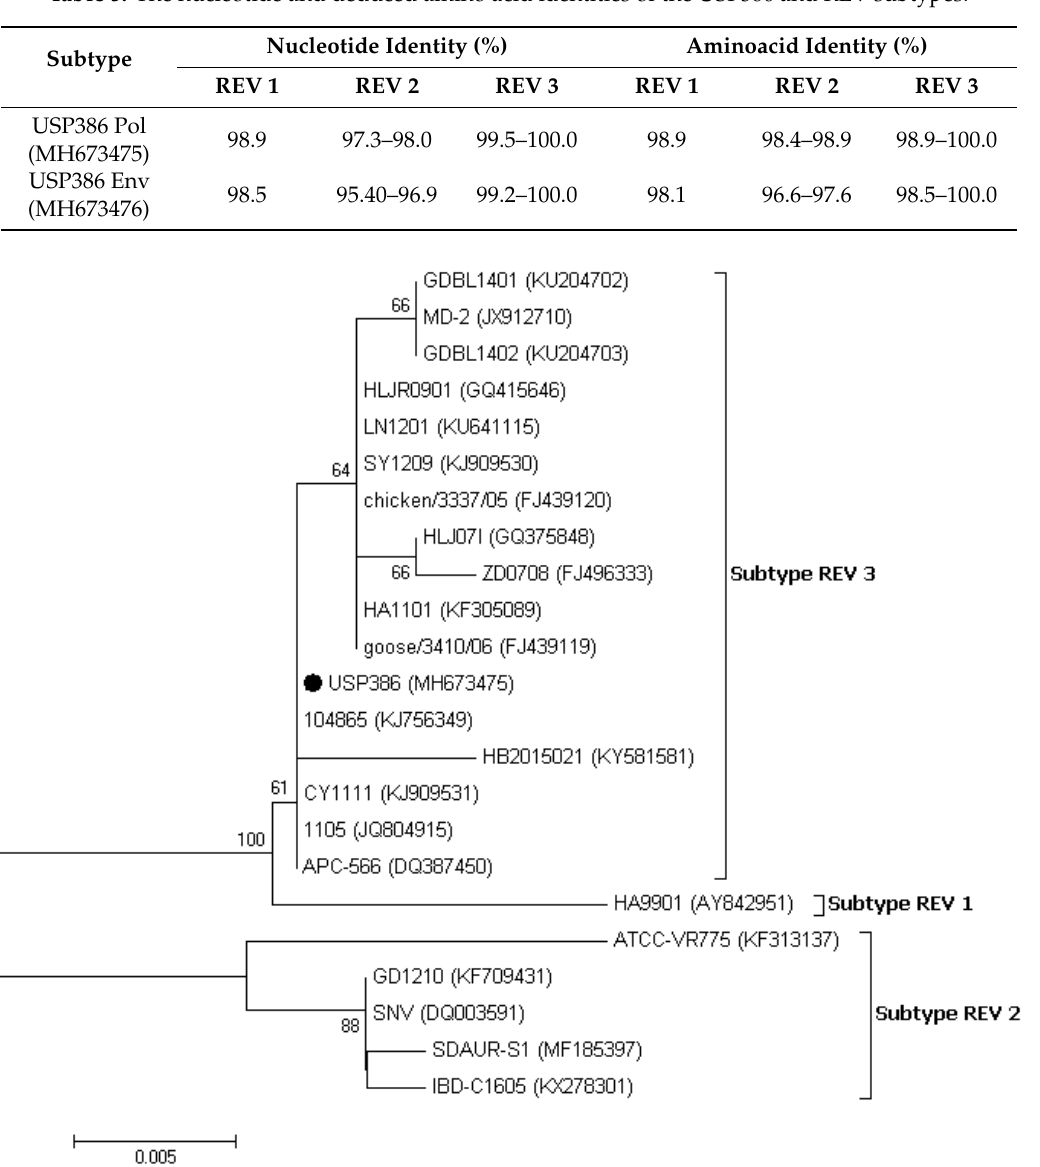
Figure 4. Phylogenetic analysis of the nucleotide sequences of the REV strains based on the partial pol gene. The strain names and GenBank accession numbers are shown. The black circle represents the field REV strain used in this study. The phylogenetic tree was constructed in MEGA v7.0 using the Neighbor-Joining method with 1000 bootstrap replicates. The evolutionary distances were computed using the Kimura 2-parameter model (K2), and the scale bar represents the number of base substitutions per site.